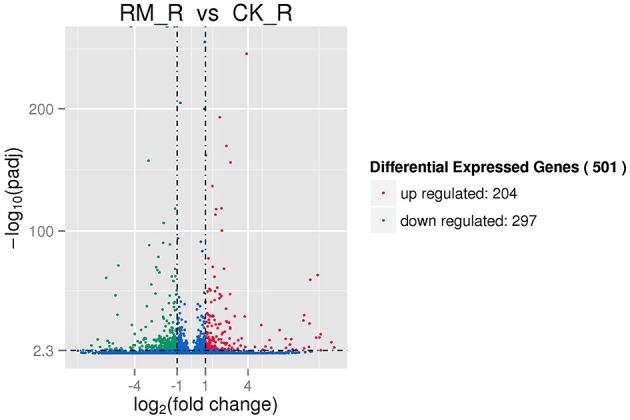
Differentially expressed genes in two samples of F. dobotrys. The significance of different expressed genes should meet to both the absolute value of log2. Fold_change. > 1 and Q < 0.005.